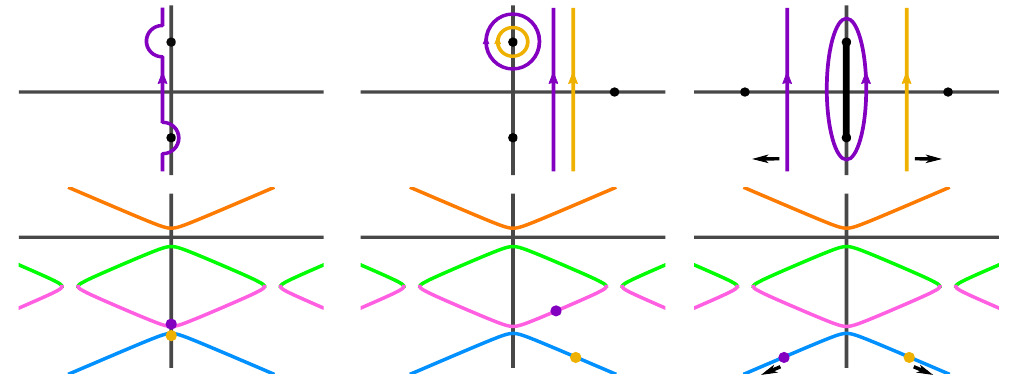
Figure 12 . The third intersection integration is analogous to the first. The integration contours will pick up residues at the poles of the cosecant as they are pulled to larger negative J